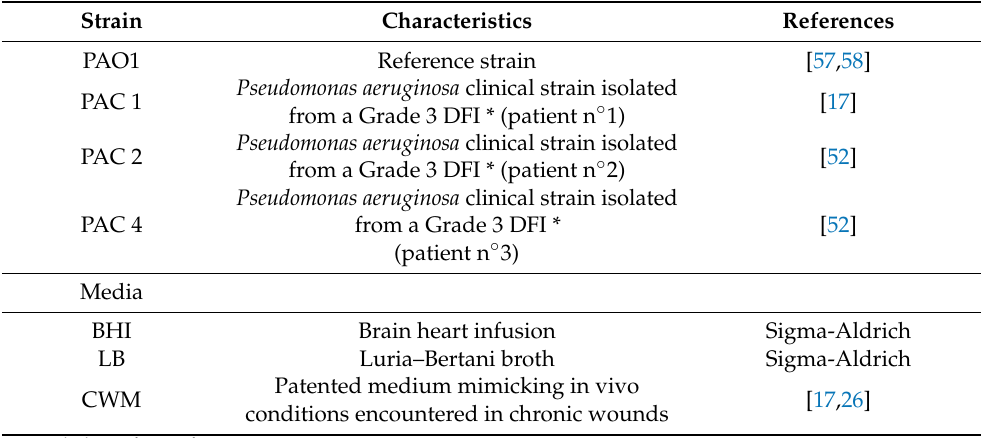
Table 4. Bacterial strains and media used in this